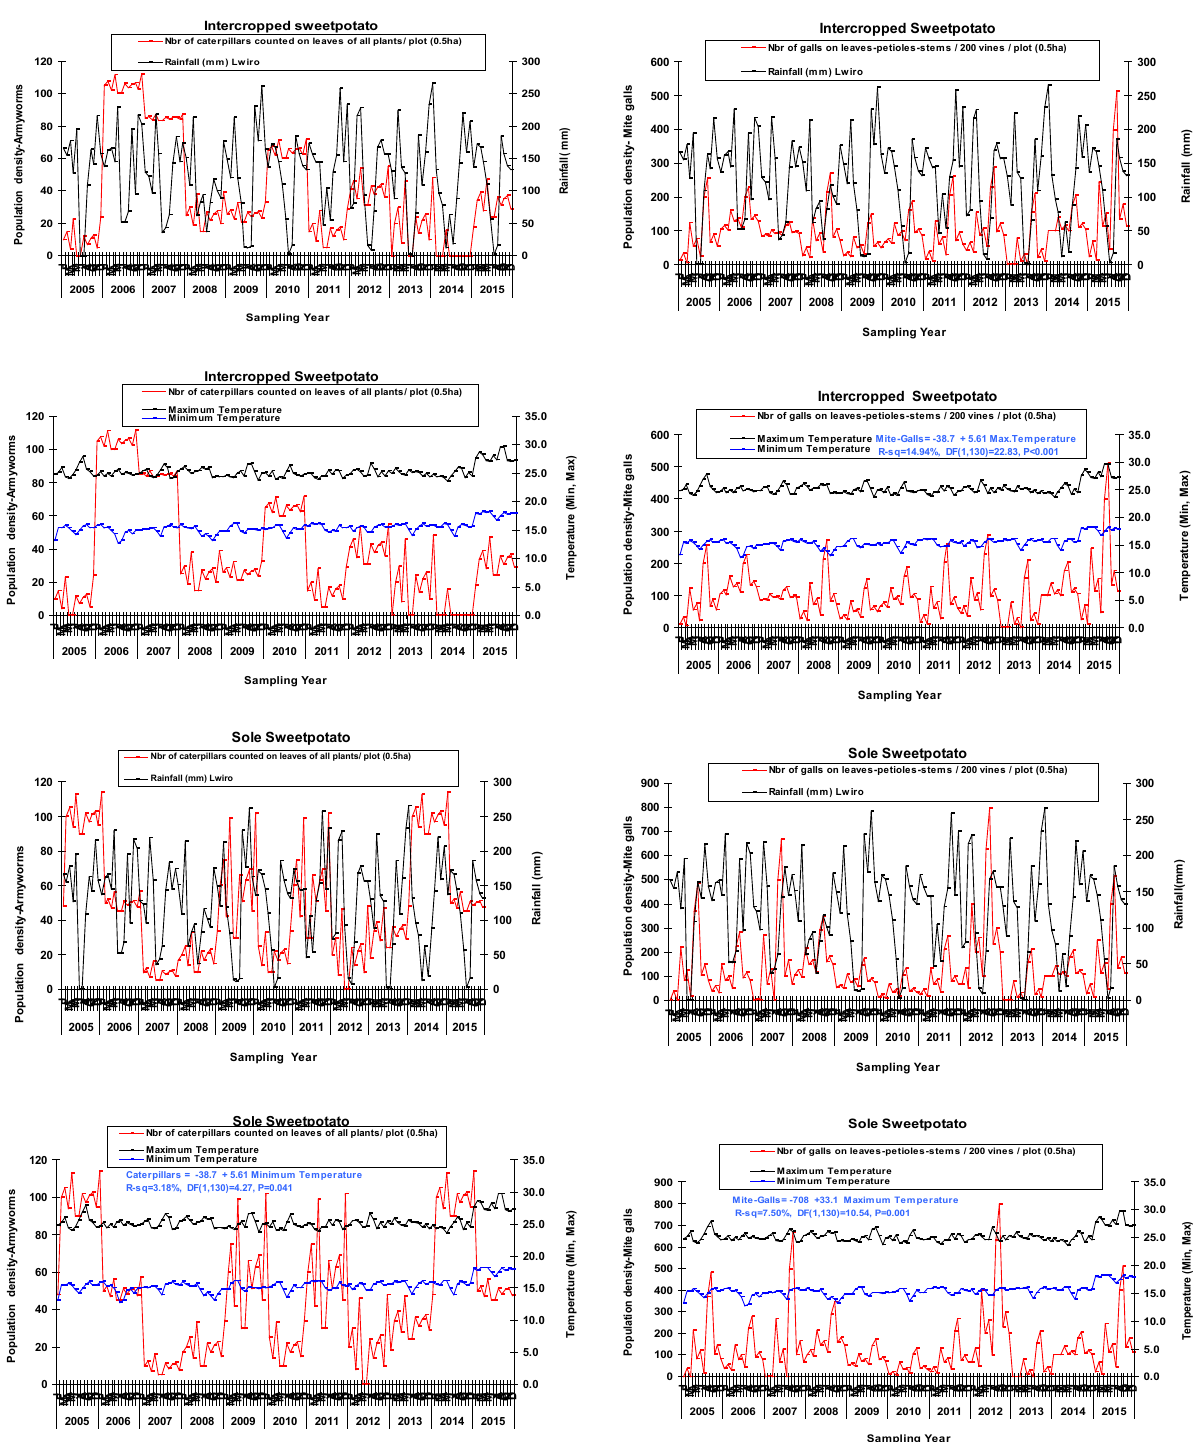
Figure 8: Fluctuation of the population density of armyworms pest in relationship with variability in climatic factors (rainfall, temperature) under intercropping and mono-cropping systems in Kivu Province, eastern DRCongo